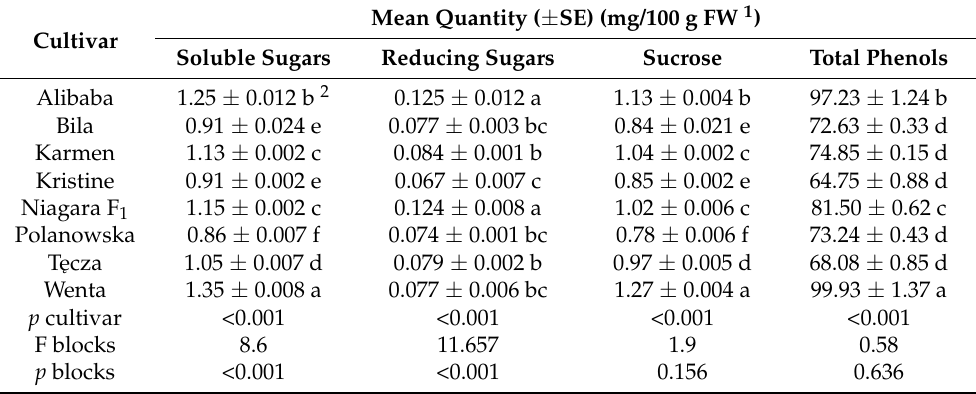
Table 3. The contents of sugars and total phenols in the not damaged by Thrips tabaci leaves of the onion cultivars in 2015, df = 7.